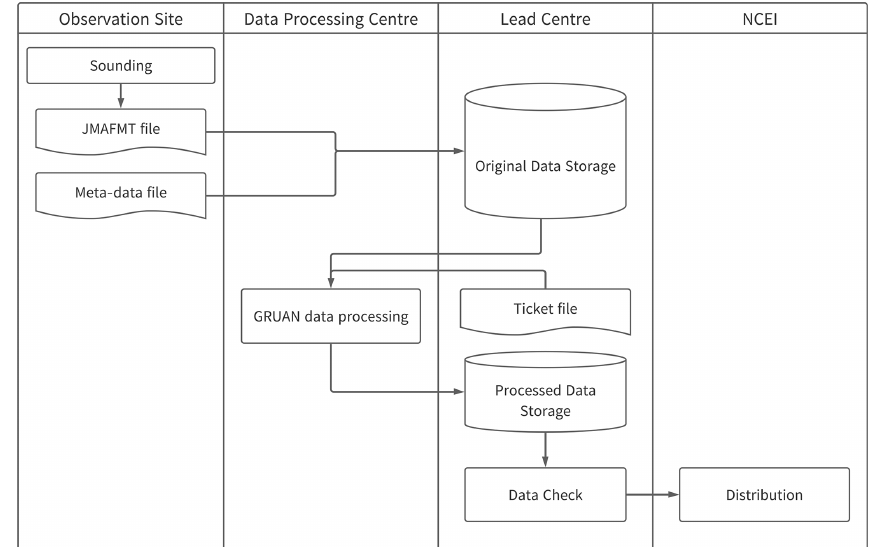
Figure 1. GRUAN data file stream.